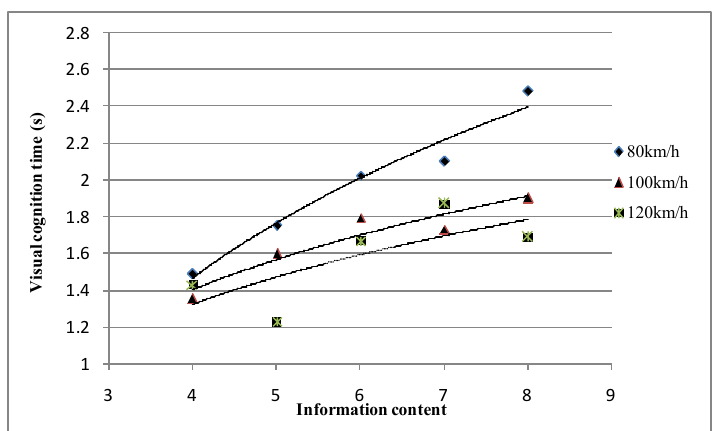
Fig.5. Correlation between visual cognition time and information content under different driving speeds